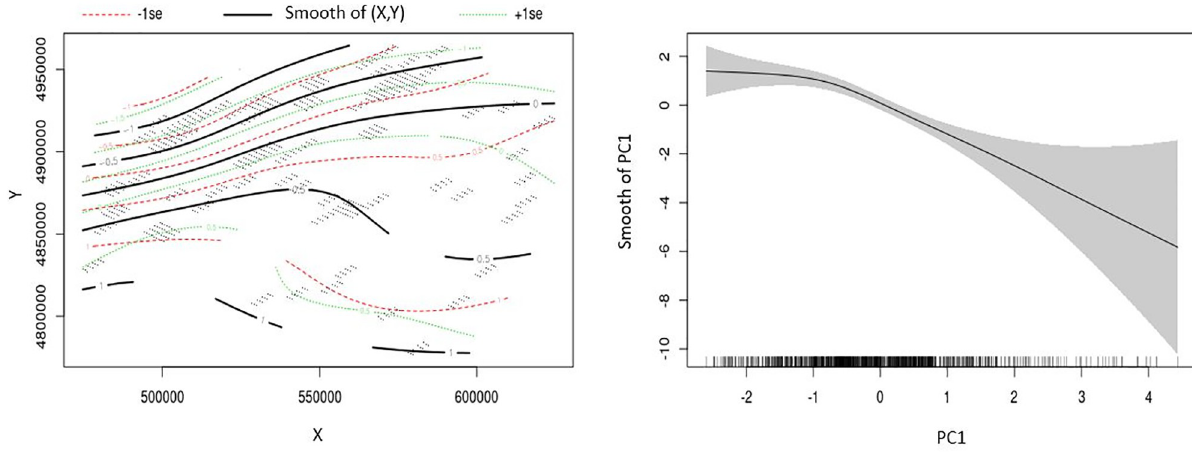
Fig 3. Partial effects of statistically significant predictors on winter abundance of white-tailed deer in the Adirondack Park, New York during 2016 according to the best fitting generalized additive model (GAM). A) Two-dimensional plot of the bivariate geographic coordinates. The solid black lines represent the smooth functions. The locations of each 2.5-km 2 survey segment are plotted as small dots. The dotted red and green lines represent − 1 standard error and +1 standard error, respectively. The number on the lines indicate whether geographic coordinates had a positive effect (e.g., +1), a negative effect (e.g., − 1), or were neutral (0) on deer abundance. B) Smooth function for the mean effect of the first principal component (PC1) (thermal cover and anthropogenic cover). The shaded area represents the 95% confidence intervals for the mean effect. The rug ticks at the bottom of the plot indicate the coverage of the range of values of each variable in the units surveyed. The number in parentheses on the y-axis indicate the effective degrees of freedom (a measure of flexibility) of each